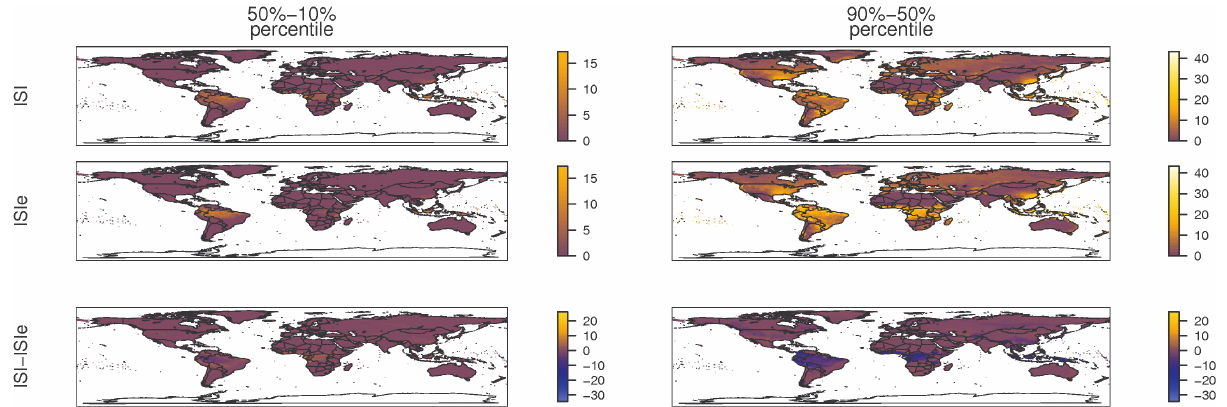
Fig. 10. The lower (50–10%) and upper (90–50%) inter-percentile range of the April daily precipitation from 1960 to 1999 are shown for the ISI-MIP dataset (ISI) and with the extended version of the algorithm (ISIe). In addition the differences of both version are shown. The inter-percentile ranges are analogues to Fig. 8. Colours refer to precipitation in mmday − 1 . Difference values outside the range of the shown colourbars are white in order to increase visibility of the map (over land this affects only few small